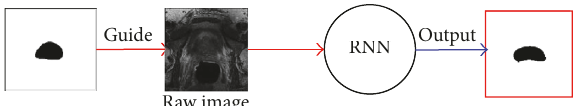
Figure 2: Interslice as shape prior to guide the process of feature